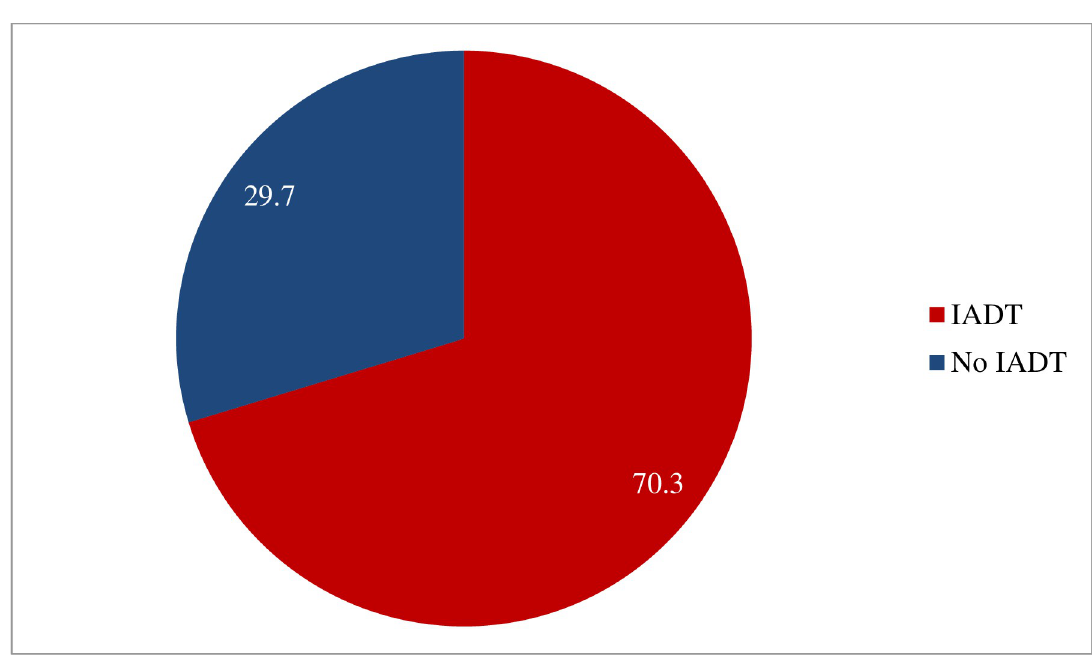
Fig 3. Prevalence of inappropriate anti-diabetic medication therapy among T2DM patients at medical and surgical wards of MRRH, Mbarara, Uganda.